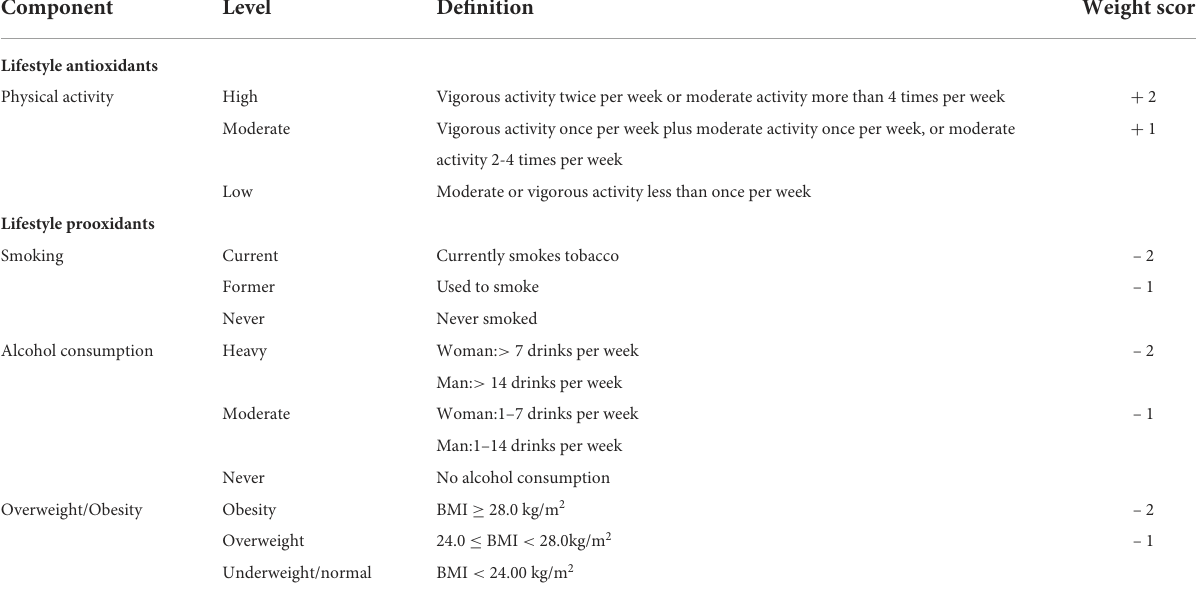
TABLE 1 Components and their weights of lifestyle-based oxidative balance scores